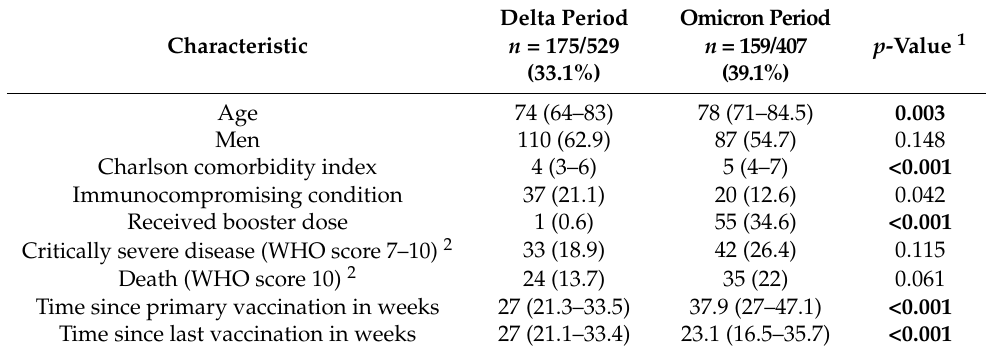
Table 4. Characteristics of patients hospitalized for vaccine breakthrough COVID-19 by study